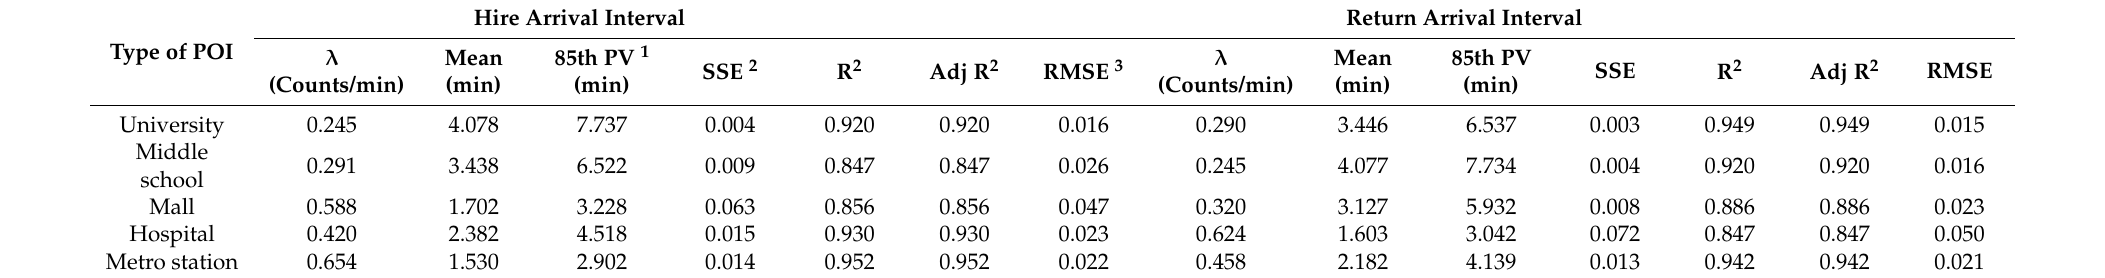
Table 2. Fitting results of arrival interval distribution of PB stations at different